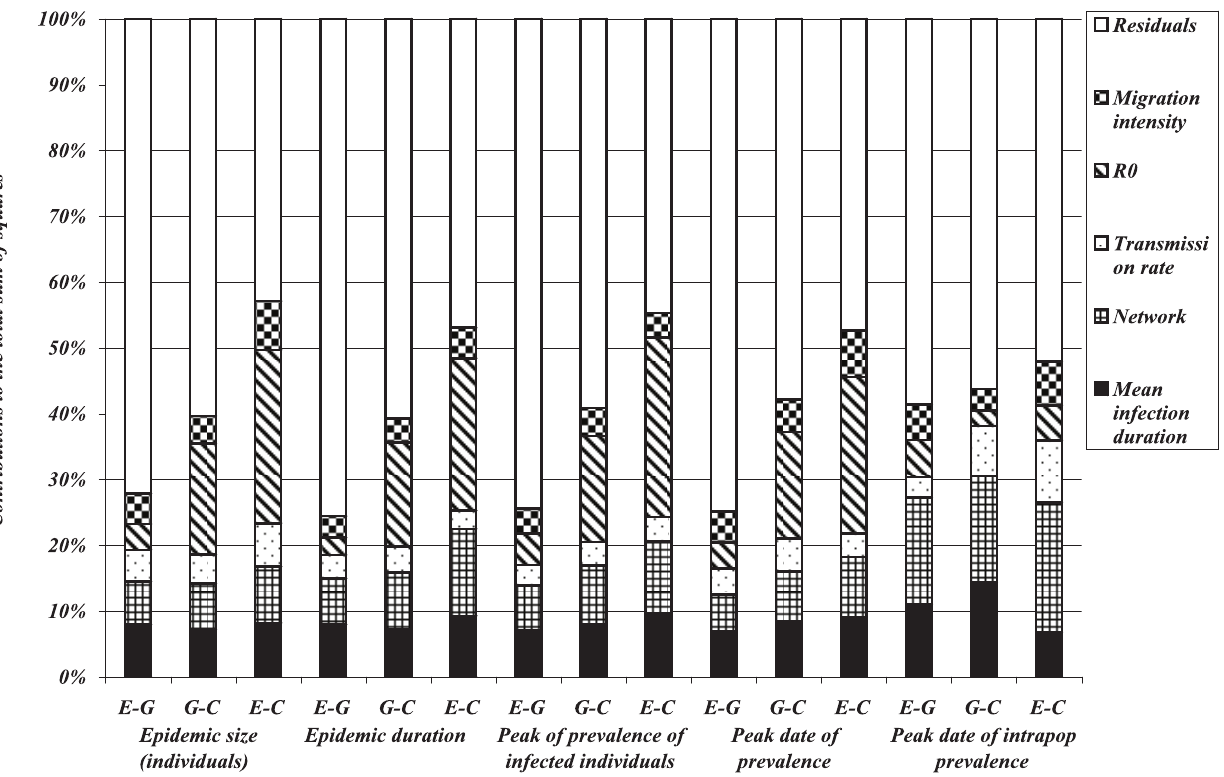
Figure 10. Results of ANOVA on 960 simulated scenarios of epidemic spread with parameter values given in Table 2. Dependent variables (on x-axis) are logarithm of variances (over the non early extinct dynamics) of global variables (directly referring to individuals regardless of their population of origin): size and duration of the epidemic , size and date of the epidemic peak and date of intra-population epidemic peak . For each of these outputs three variants are considered with respect to the distribution of infection duration: ’ E { G ’ (difference between the value of the output simulated with the exponentially distributed infectious period and the value corresponding to the gamma distributed infectious period), ’ G { C ’ (difference between the value of the output simulated with the gamma distributed infectious period and the value corresponding to a constant infectious period) and ’ E { C ’ (difference between the value of the output simulated with the exponentially distributed infectious period and the value corresponding to a constant infectious period). Different pattern fills correspond to contributions of five input factors ( mean infection duration , network , transmission rate , R 0 and migration intensity ) to the variation in outputs amongst scenarios.